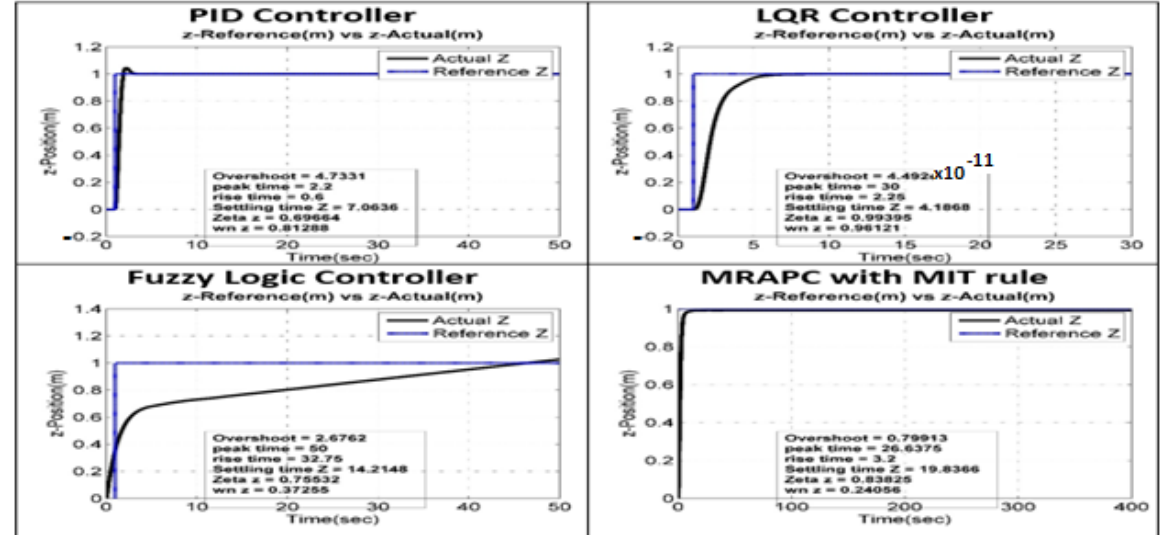
Figure 15. Step response result of all control systems along the z − axis